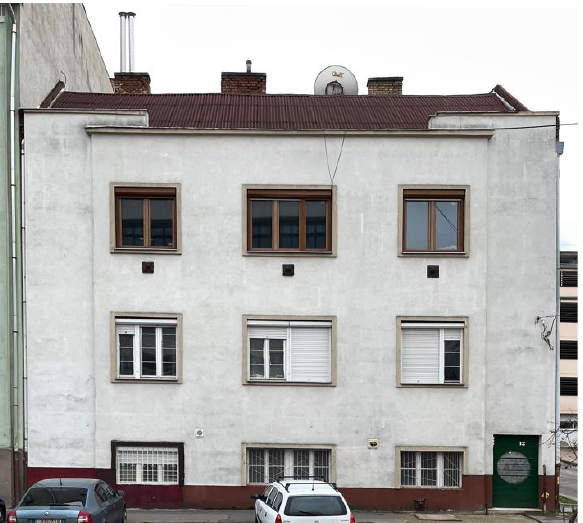
Figure 15. 12 Régiposta street. Street façade. Architect: Victor Bohm, 1932 – 1934. Source: Lovra Figure 15. 12 R é giposta street. Street façade. Architect: Victor Bohm, 1932–1934. Source: Lovra 2021.